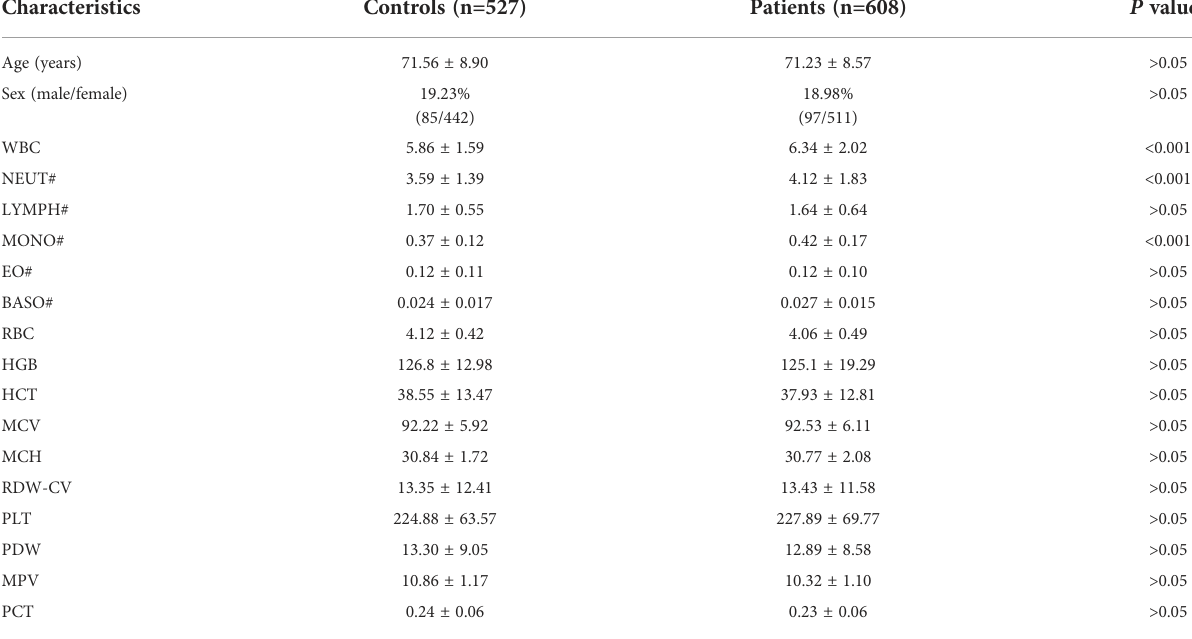
TABLE 1 Characteristics and hematological indices of osteoporotic patients.